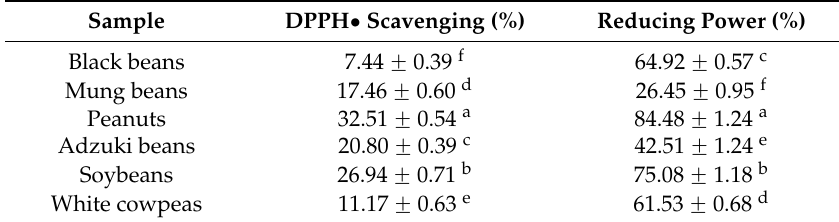
Table 3. Antioxidant activities of 5-day germinated legume extracts.